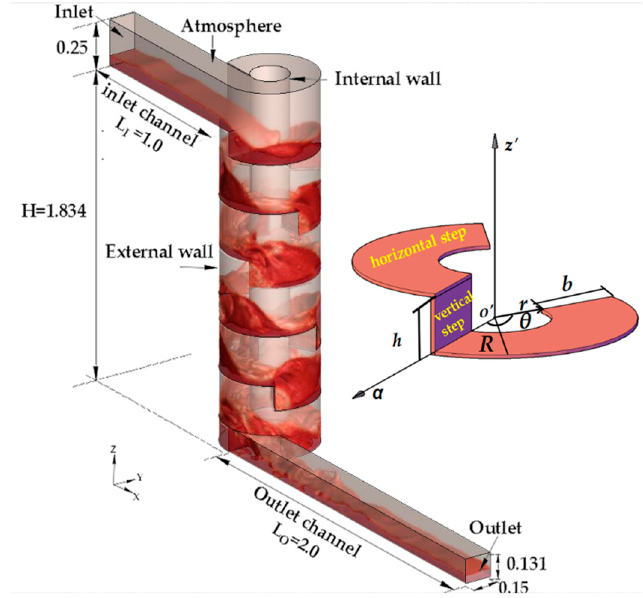
Figure 1. Computational model of the dropshaft.